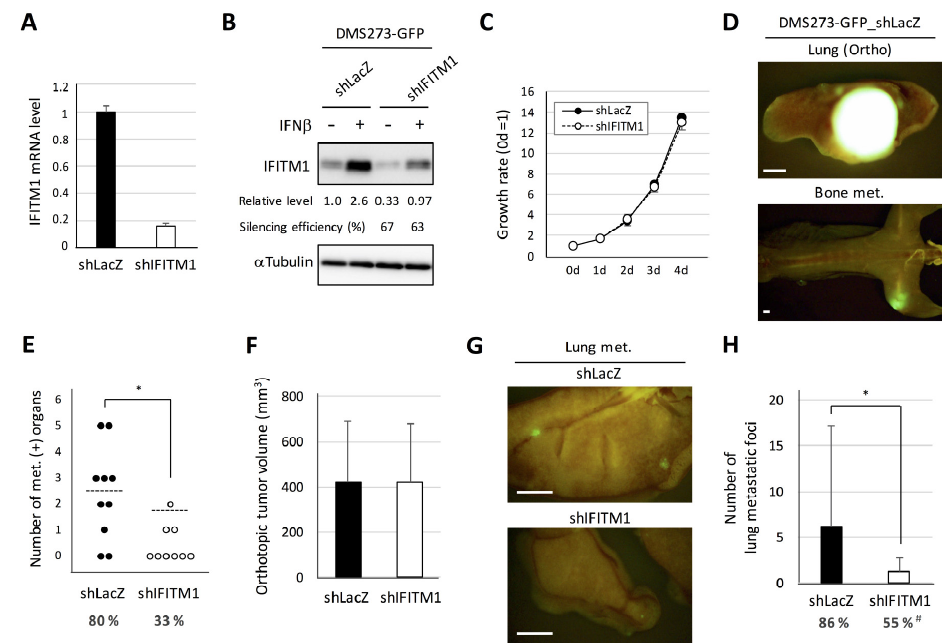
Figure 5. Effect of IFITM1 silencing on the metastatic formation of DMS273-GFP cells in nude mice. ( A ) Quantitative analysis of IFITM1 mRNA in silenced cells. One microgram of total RNA